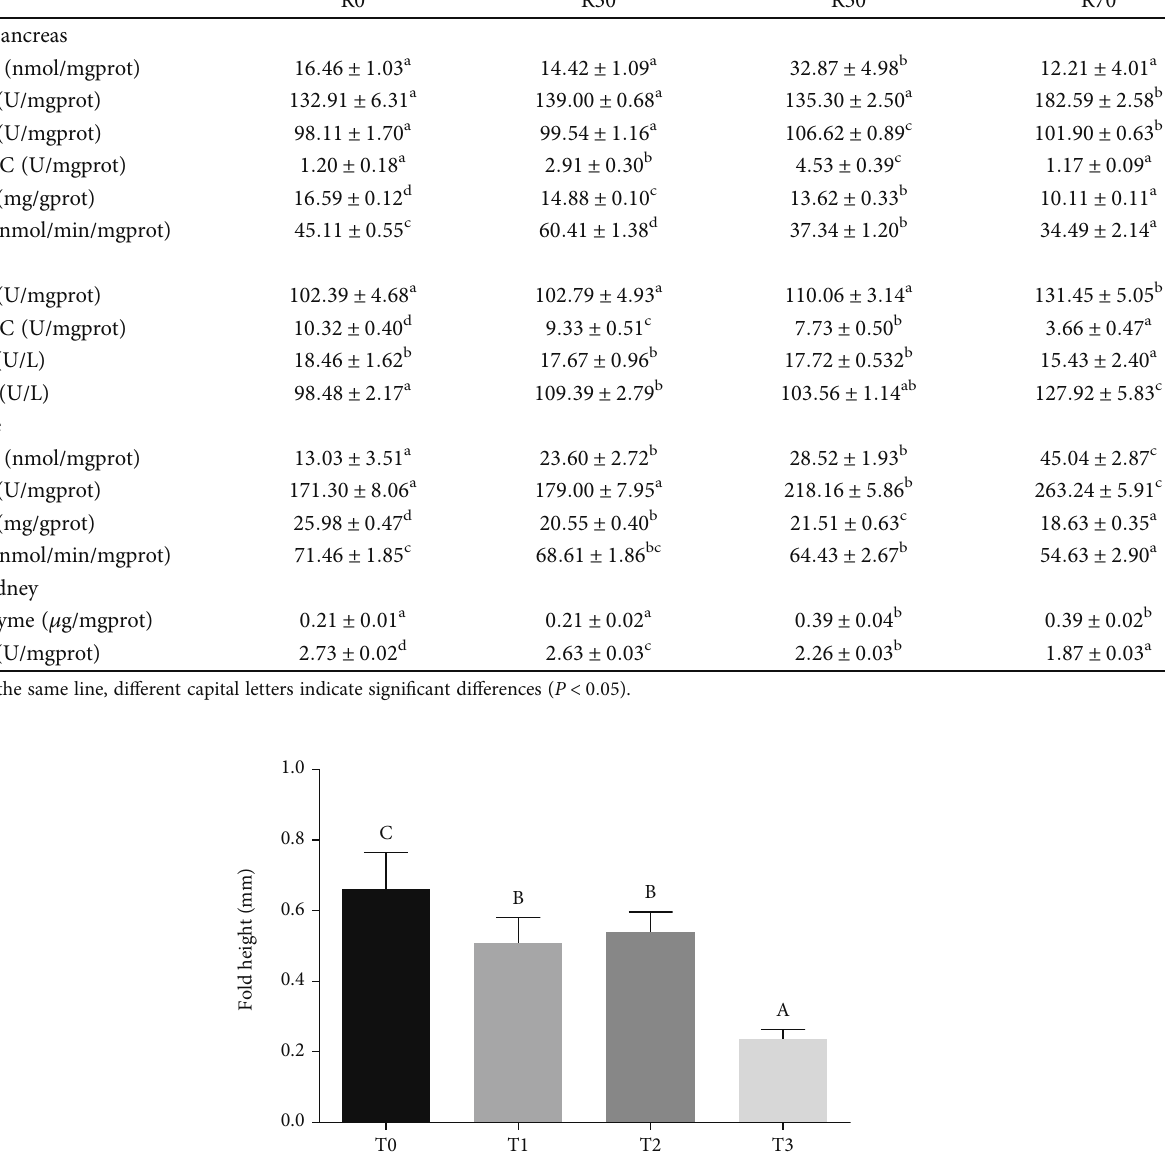
Table 7: Biochemical and immune parameters in di ff erent tissues of grass carp fed practical diets ( means ± SD , n = 3 ). R0 R30 R50 R70 Hepatopancreas